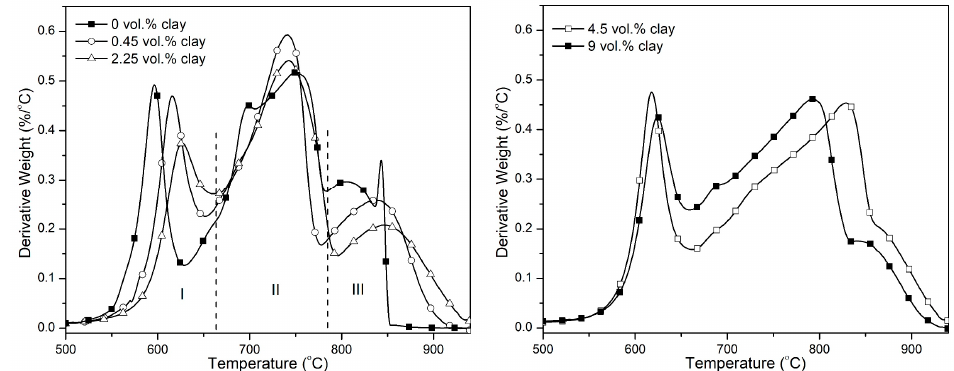
Figure 8. Derivative TGA curves of PI-NGS-Clay nanocomposites showing the degradation regions for (I) imide unit and (II) the polymer char (III) graphene and clay. for (I) imide unit and (II) the polymer char (III) graphene and